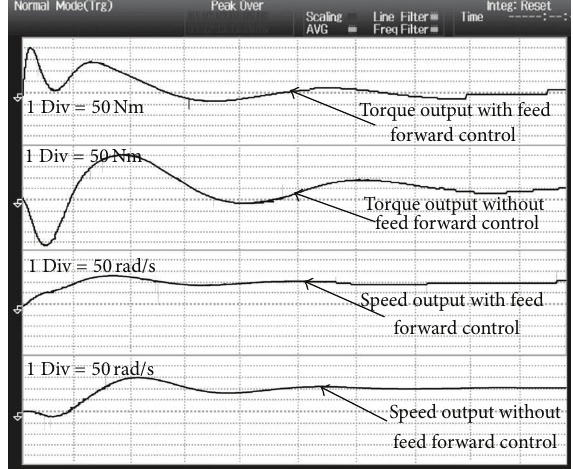
Figure 16: Experimental result torque-speed response of IOL control